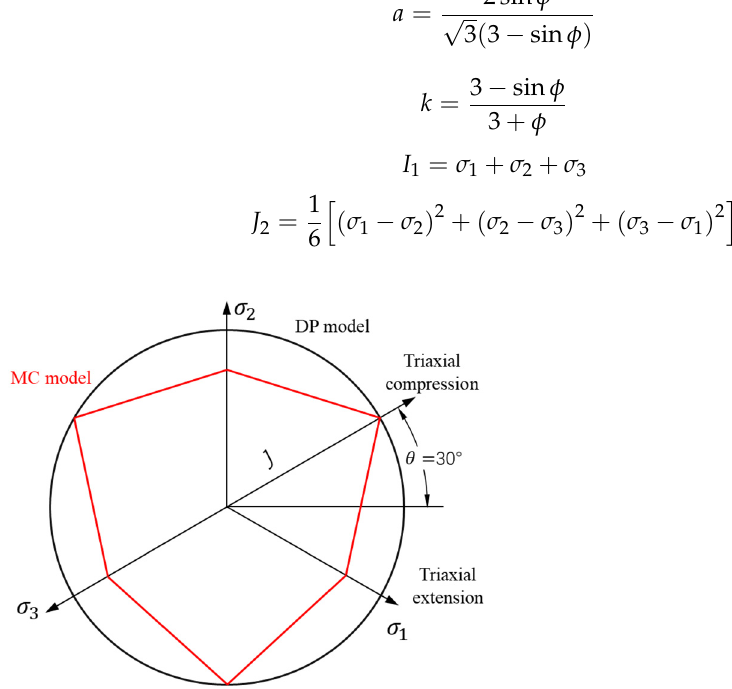
Figure 3. Drucker–Prager (DP) and Mohr–Coulomb (MC) models in the deviatoric plane.